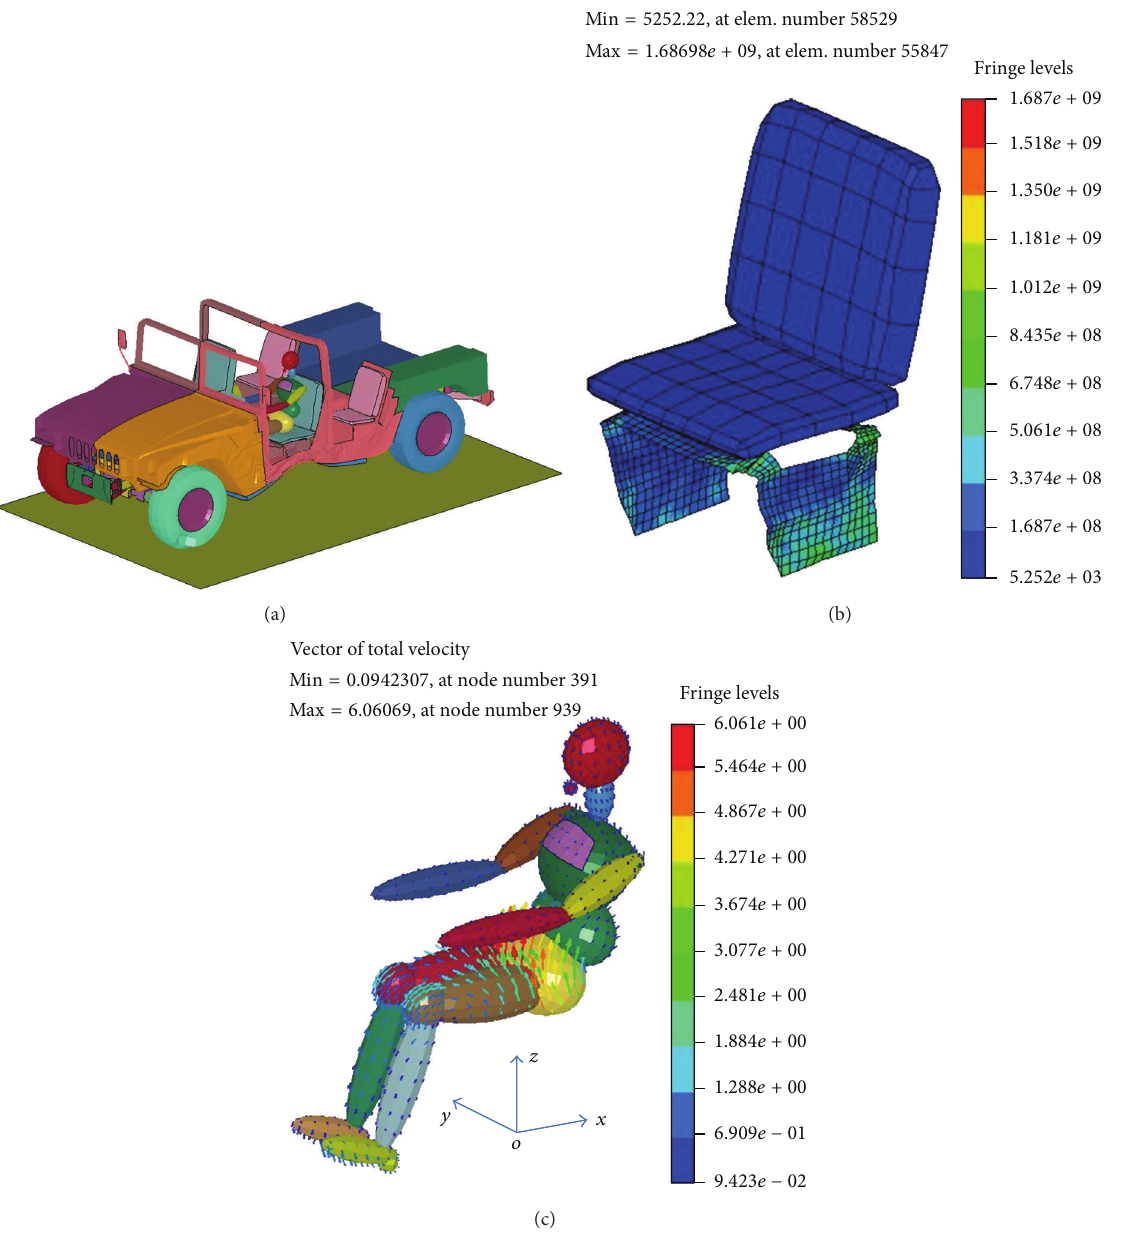
Figure 5: Simulations results. (a) Vehicle deformation. (b) Deformation and effective stress distribution of seat mounts. (c) Resultant velocity of